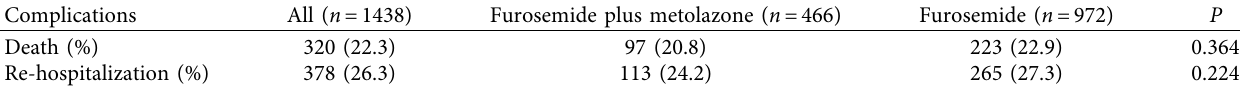
Table 2: Distribution of death and re-hospitalization across different categories of diuretic usages.